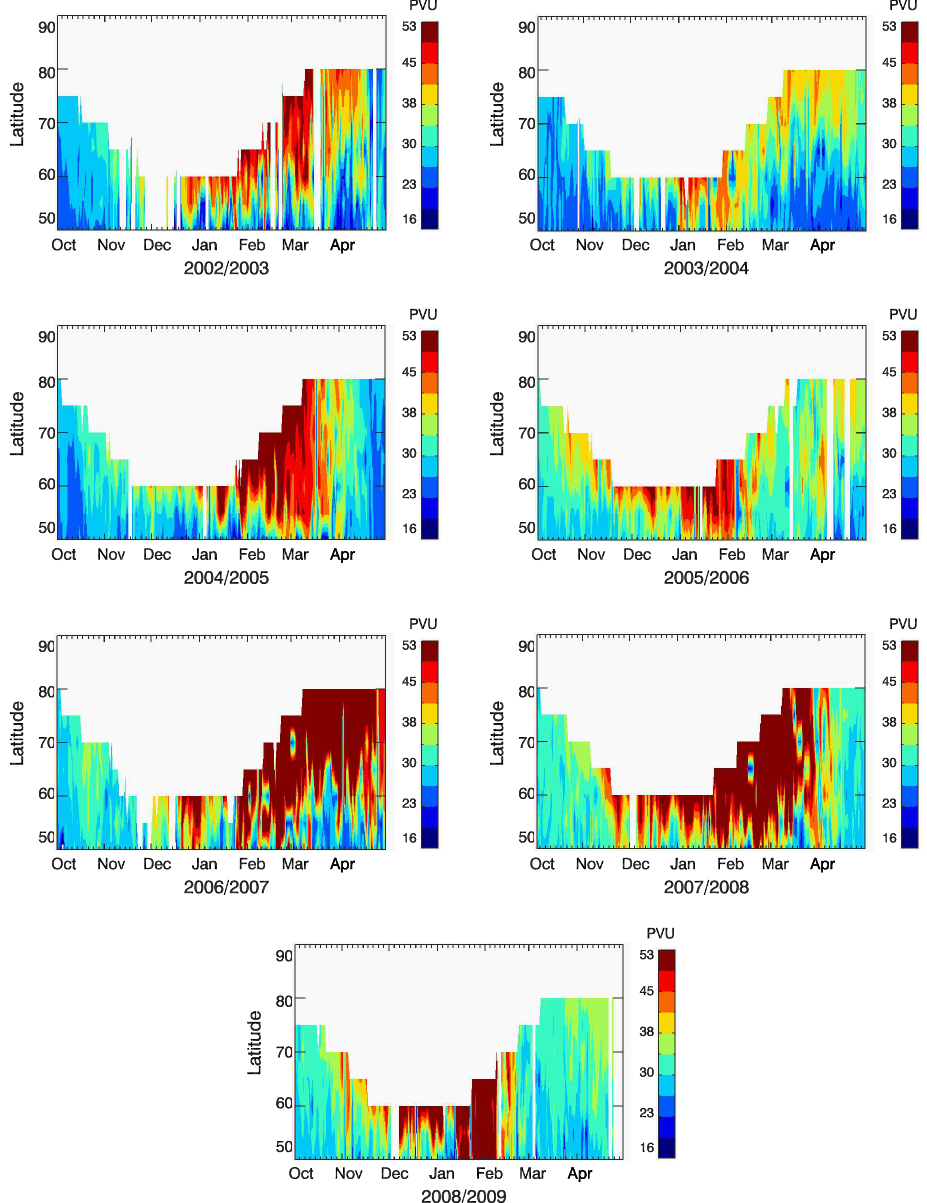
Fig. 2. Daily and zonal maximum modified potential vorticity at the 475K isentropic level in the Arctic stratosphere for latitudes of SCIA- MACHY observations in 2002–2009 during winter/spring (given in potential vorticity units (PVU)). Data averaged over 5 ◦ latitude bins.